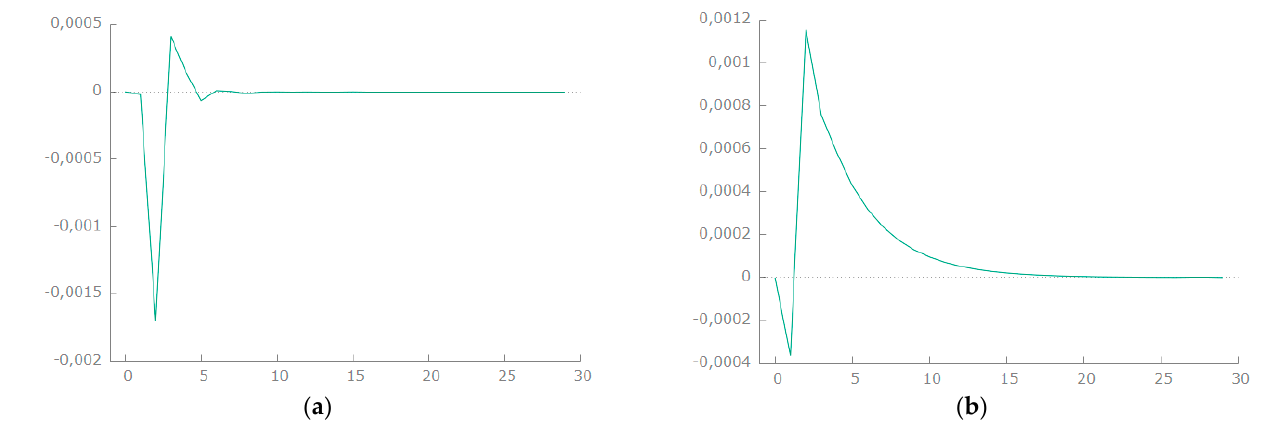
Figure 1. Examples of functions of the rate of return reaction for Tauron, Katowice to an impulse: ( a ) insolation; ( b ) average daily relative humidity.